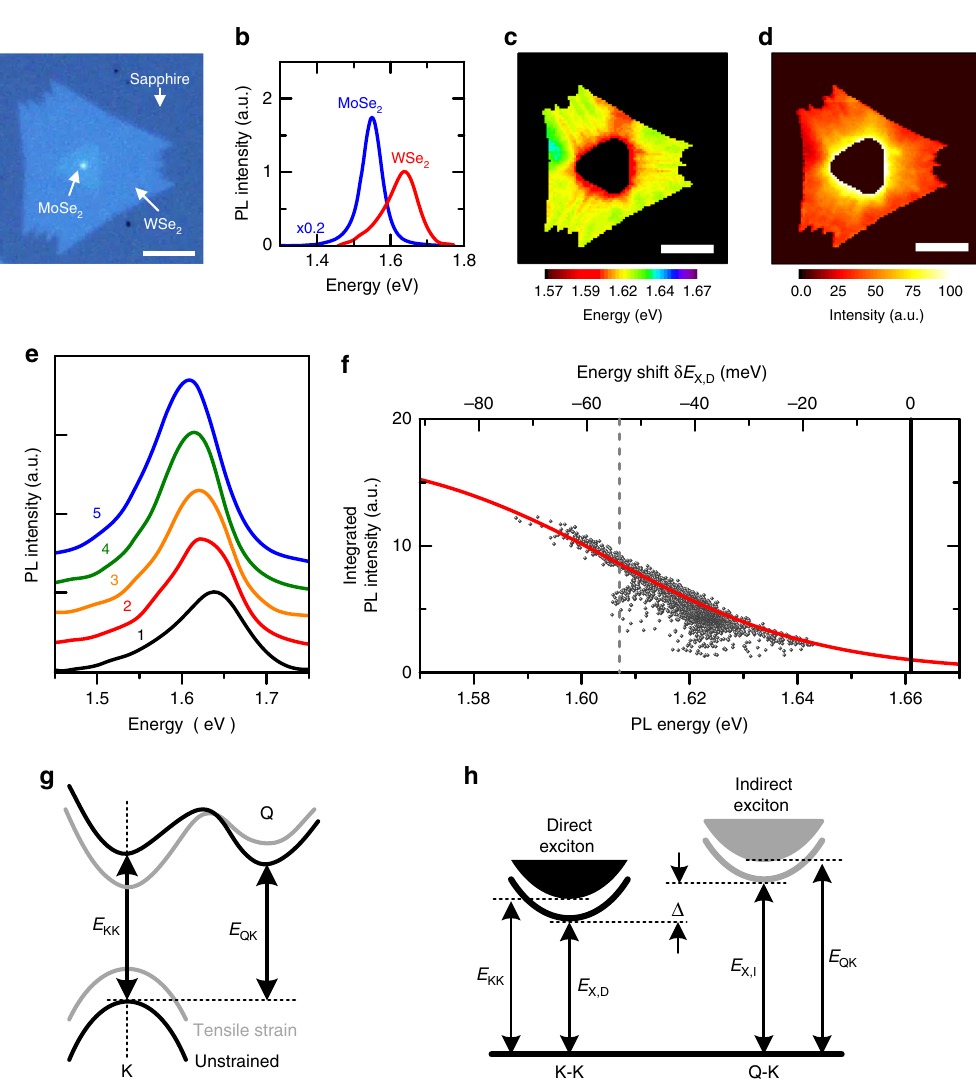
Fig. 2 PL inhomogeneity in strained MoSe 2 – WSe 2 lateral HJs. a Optical image of a monolayer MoSe 2 – WSe 2 HJ. b The PL spectra of the inner MoSe 2 and the outer WSe 2 . c , d Contour color maps of the PL peak energy ( c ) and intensity ( d ) of outer WSe 2 . e Five selected PL spectra from the outer WSe 2 . ( f ) Integrated PL intensity as a function of peak energy (black dots). Solid line is the model fi tting curve. The top axis is the PL peak energy shift with respect to the unstrained WSe 2 . g Schematics for the band structures of monolayer WSe 2 without (black) and with (gray) tensile strain. h Schematics for the direct (K-K) and indirect (Q-K) excitonic states with energies of E X,D and E X,I ,